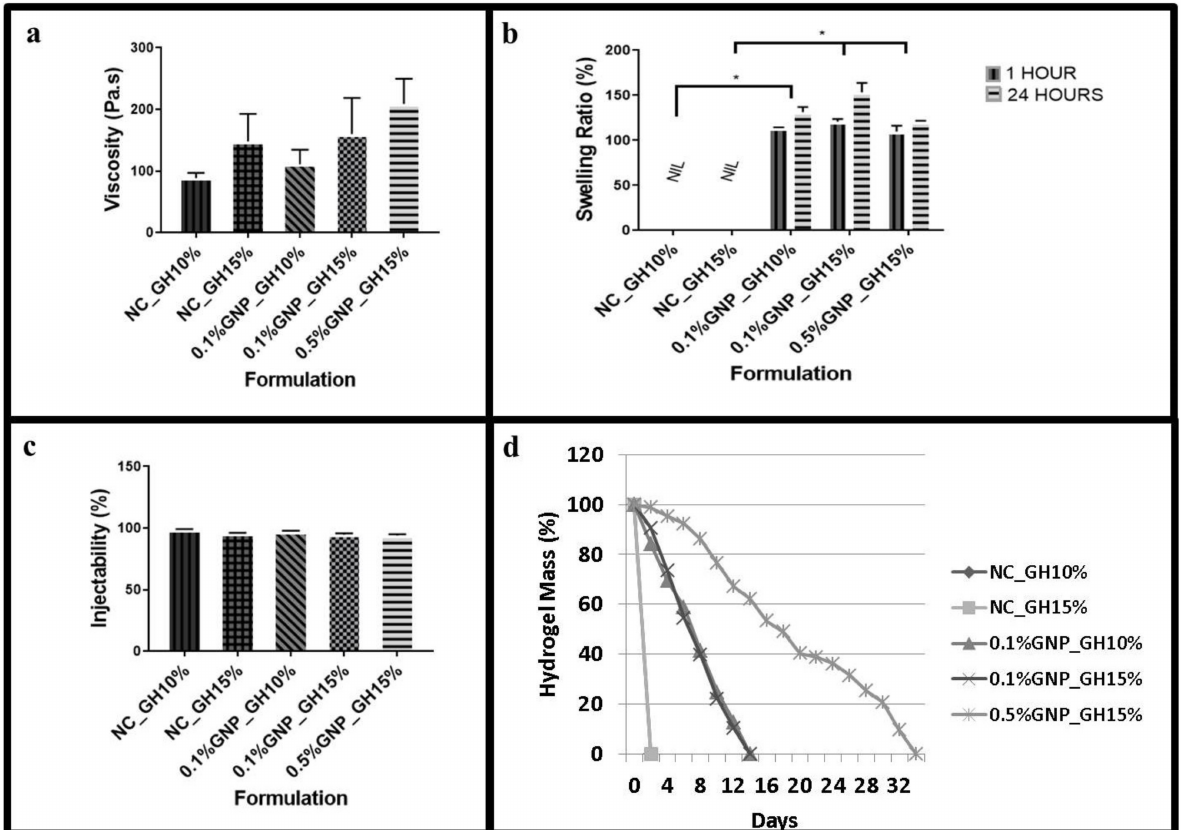
Figure 2. Fluidity, swelling and biodegradation test. ( a ) Viscosity values of GNP_GH were slightly higher than NC_GH. GNP_GH groups were considered as injectable systems. ( b ) NC_GH groups were not stable in PBS solution. Meanwhile, GNP_GH groups exhibited a good swelling ratio (>100%) after 1 day of PBS exposure. ( c ) GNP_GH groups revealed high injectability (>90%). ( d ) NC_GH groups were not stable in the enzyme environment and GNP_GH groups were resistant against collagenase degradation. * represented significant difference ( p < 0.05, n = 3, N =